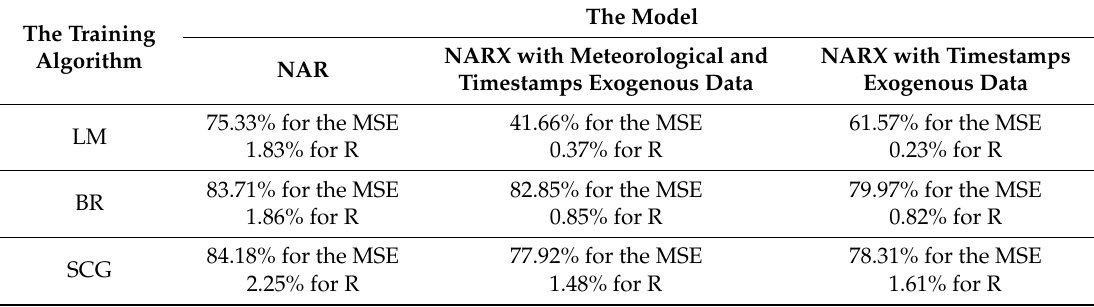
Table 8. The performance metrics improvement when comparing the best with the worst mix ( n , d )